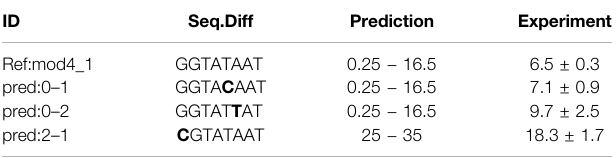
TABLE 2 | Performance of newly designed promoters. The reference promoter Ref:mod4_1 was measured in the original data set and differs from the designedpromotersonlybysinglenucleotide changes.Intheoriginaldataset,the reference promoter displayed a GFP expression activity of 9 ± 2 Units.